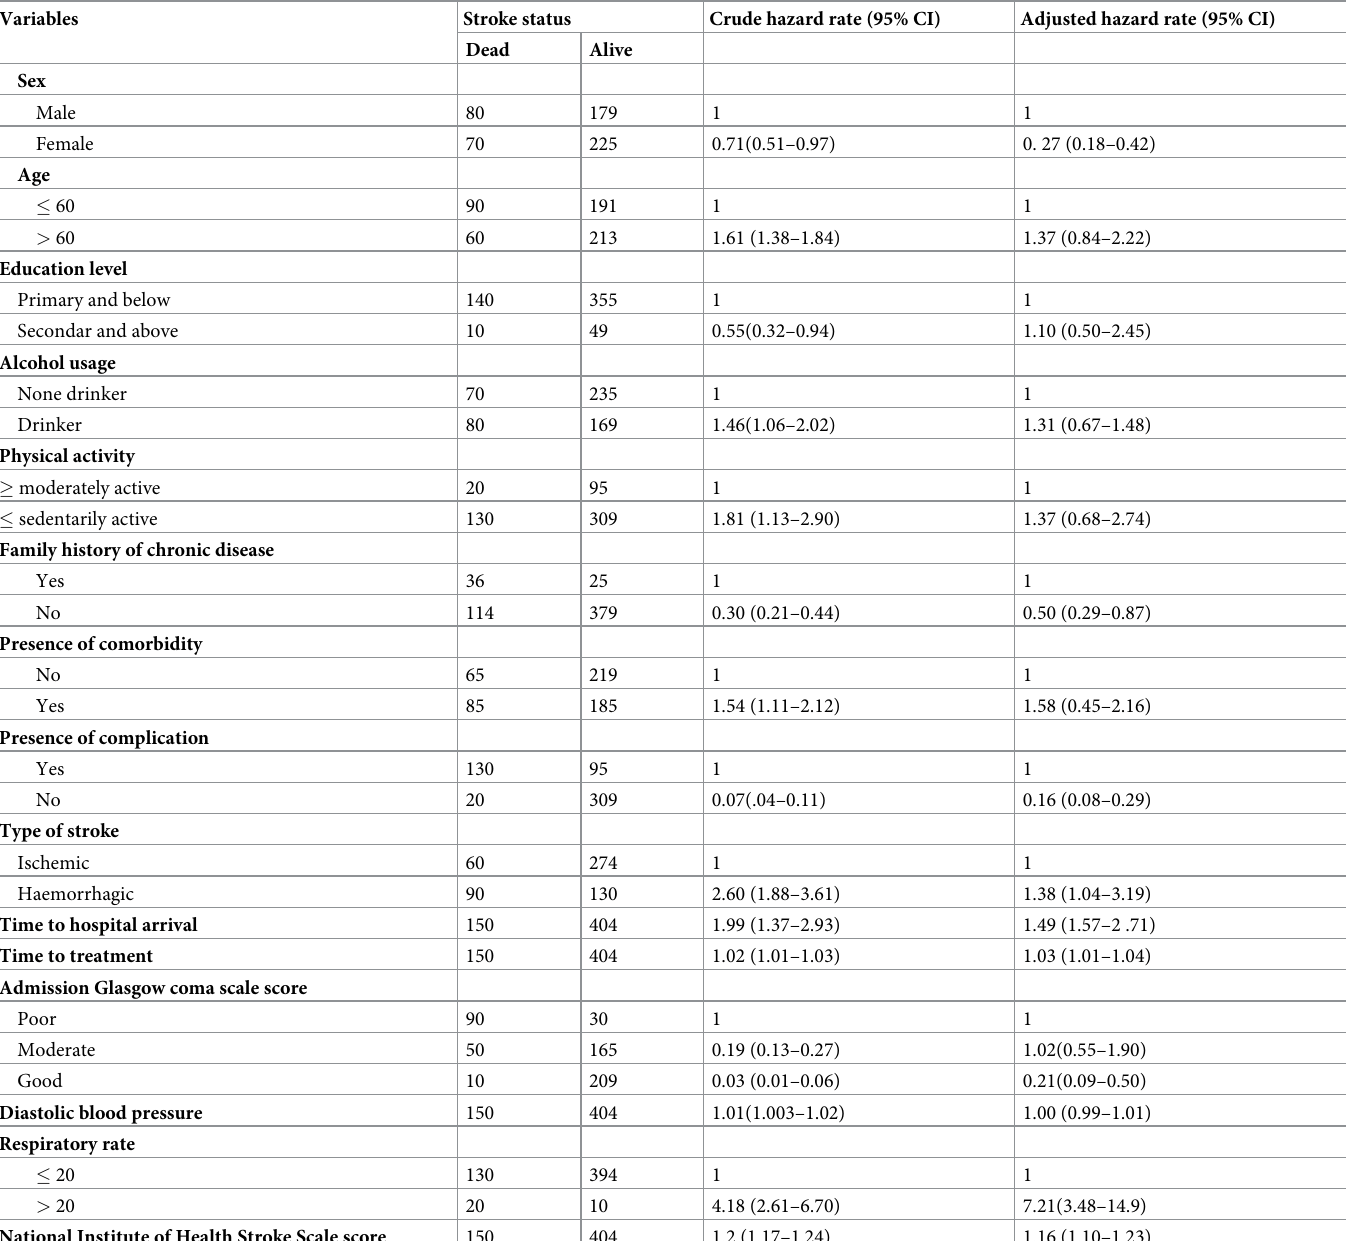
Table 3. Determinants of 28 days case fatality rate among admitted stroke patients in public referral hospitals in Northwest Ethiopia, 2020/21.